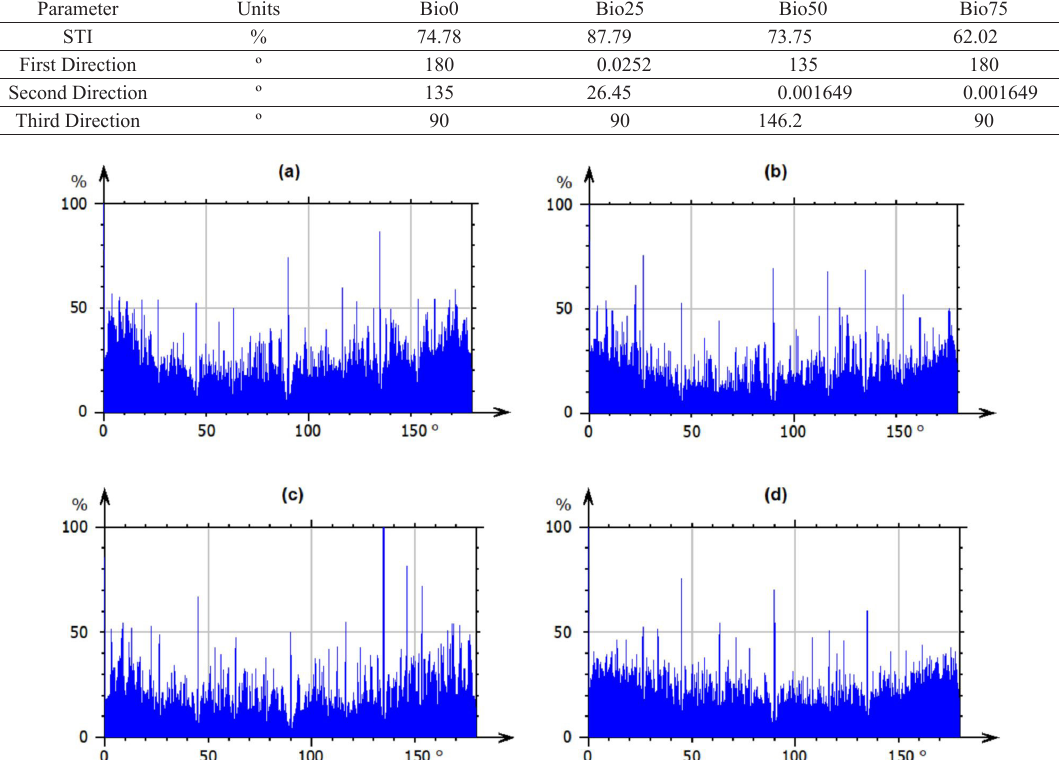
Figure 6. The representation of surface texture directions of the more relevant analyzed samples for a) Bio0, b) Bio25, c) Bio50, and d)